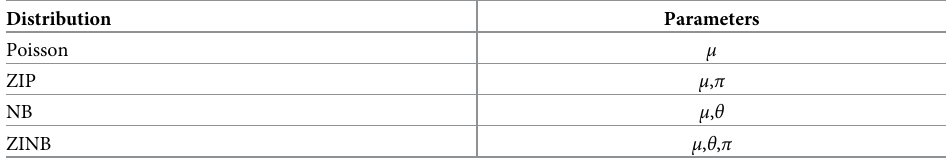
Table 1. Parameters for different